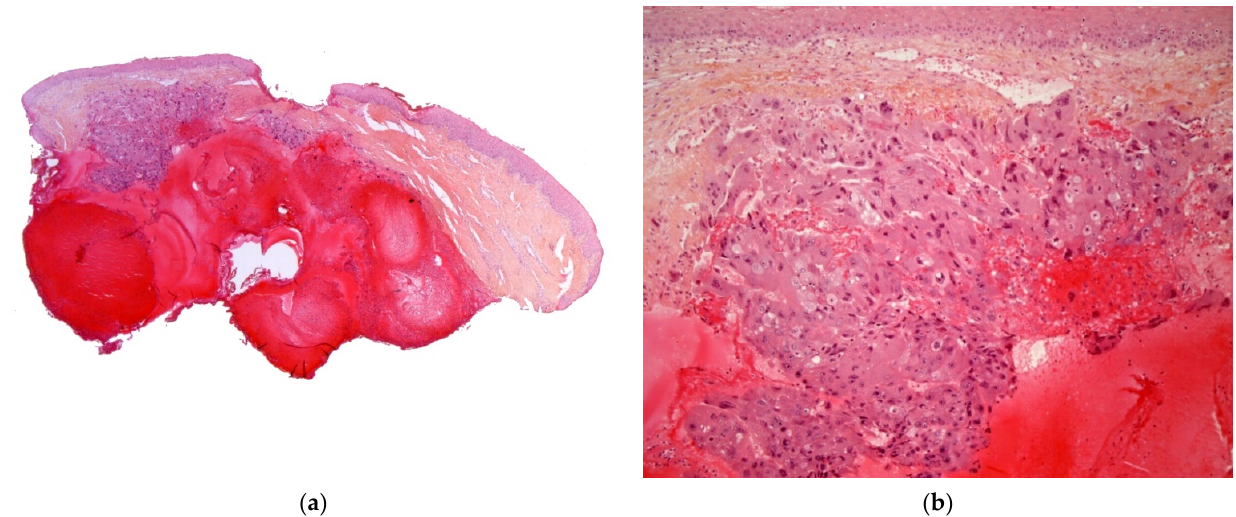
Figure 9. Metastatic choriocarcinoma. ( a ) 4× cellular and hemorrhagic areas in the reticular dermis arranged in lobules. ( b ) 25× very large typical cells of syncytiotrophoblast.